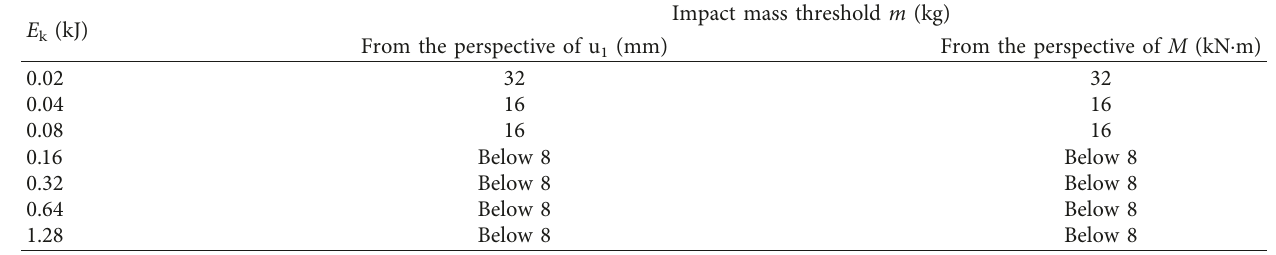
� 0.02kJ, M � 256kg. k